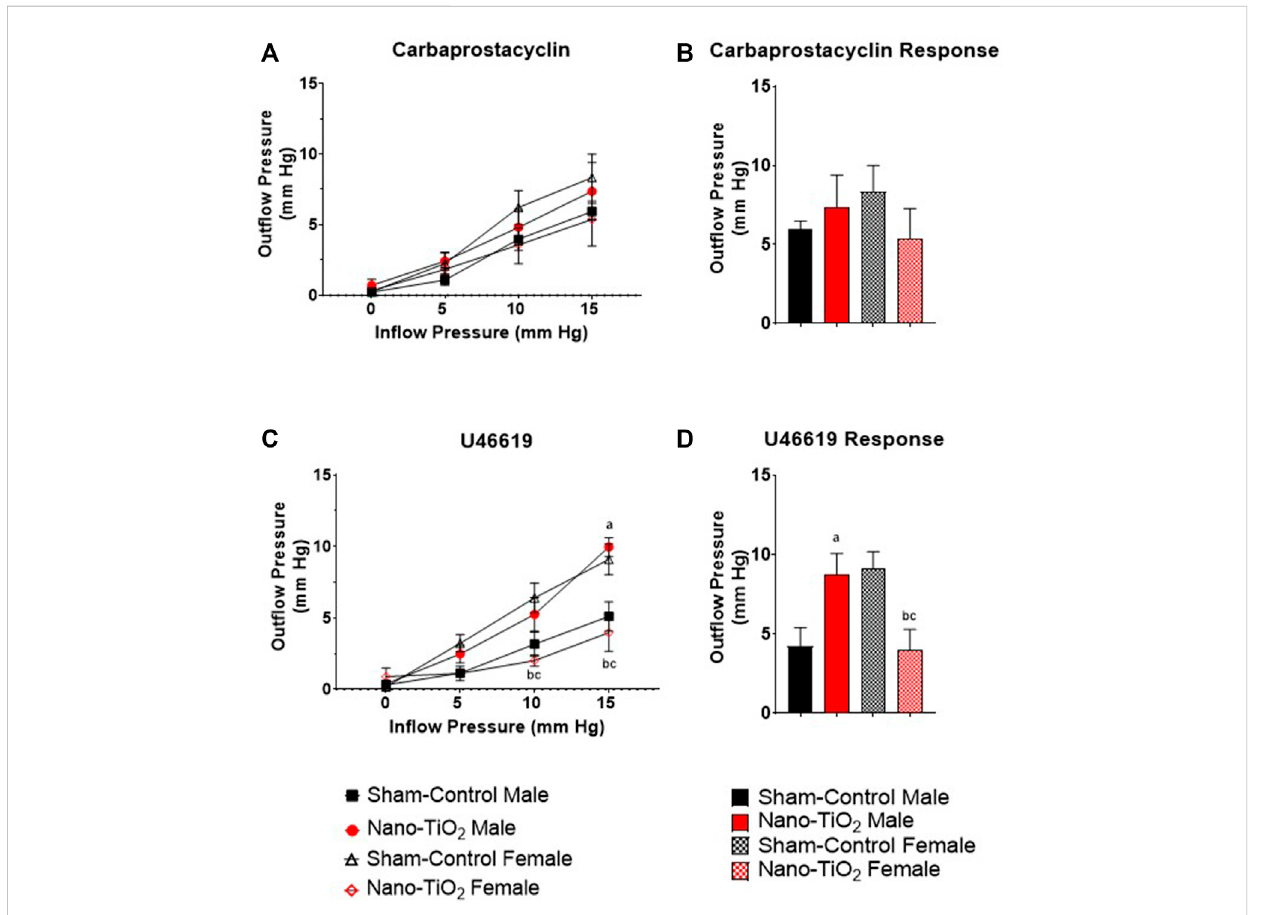
FIGURE 4 PlacentalCyclooxygenaseMetabolitesOut fl owHemodynamics.Out fl owpressurereadingswererecordedwithincreasedin fl owinput. (A) Placental out fl ow pressure in the presence of carbaprostacyclin, a stable PGI 2 agonist. (B) Maximum out fl ow response to carbaprostacyclin. (C) Out fl ow pressure with U46619, the TXA 2 mimetic. (D) Maximum out fl ow pressure response in the presence of U46619. Sham-control fetal male, n = 5-6, nano-TiO 2 fetal male, n = 5-7, sham-control fetal female, n = 4-5, and nano-TiO 2 fetal female, n = 5 – 6. a, p ≤ 0.05 vs sham-control fetal male. b, p ≤ 0.05 vs sham- control fetal female. c, p ≤ 0.05 vs nano-TiO 2 fetal